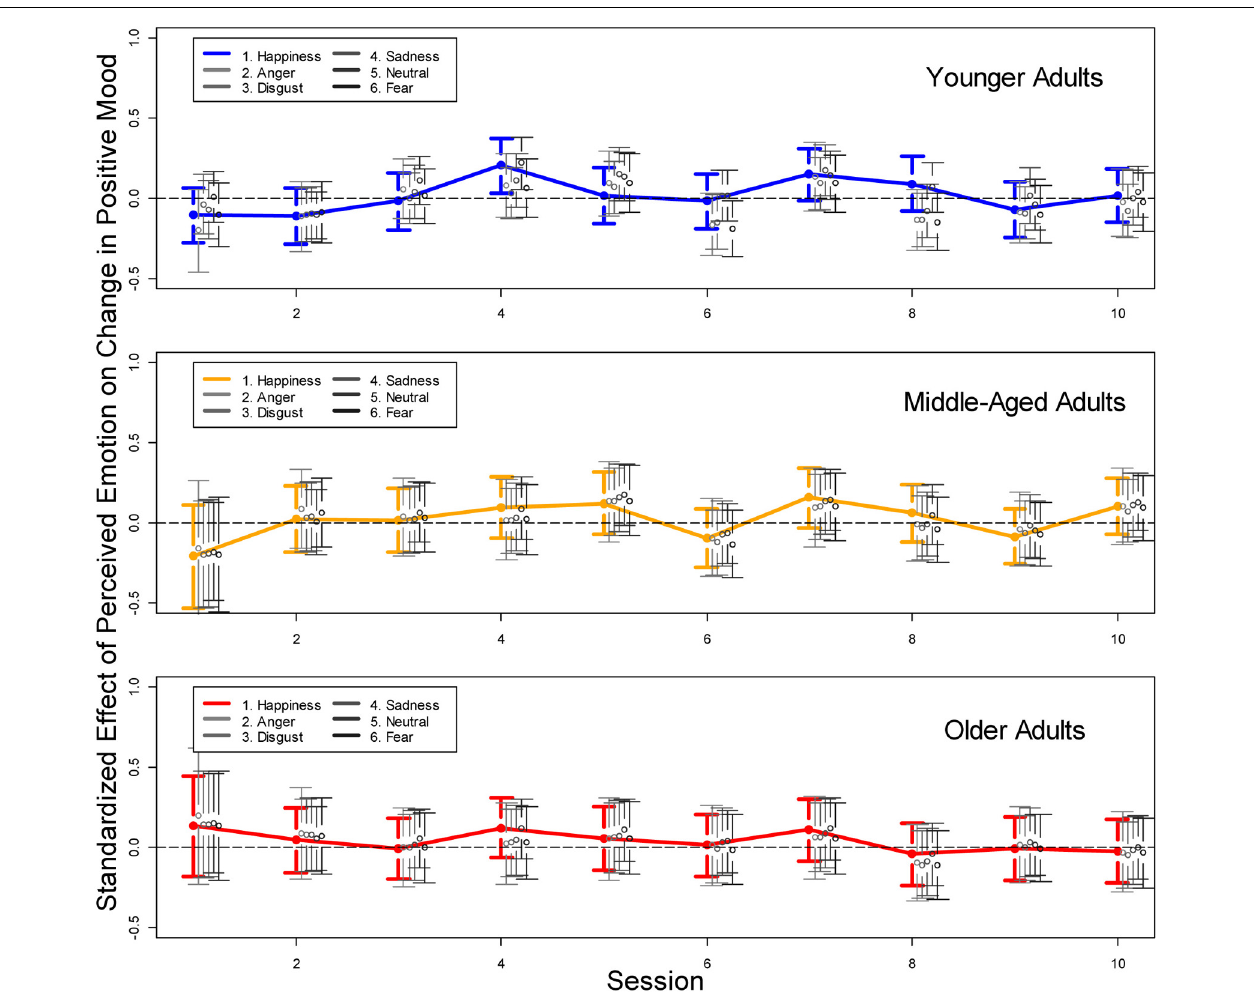
FIGURE 4 | Standardized effects of perceived happiness, anger, disgust, sadness, neutrality, and fear on changes between pre- to post-session mood for younger, middle-aged, and older participants. In six separate analyses (for the six emotions), the interaction between perceived